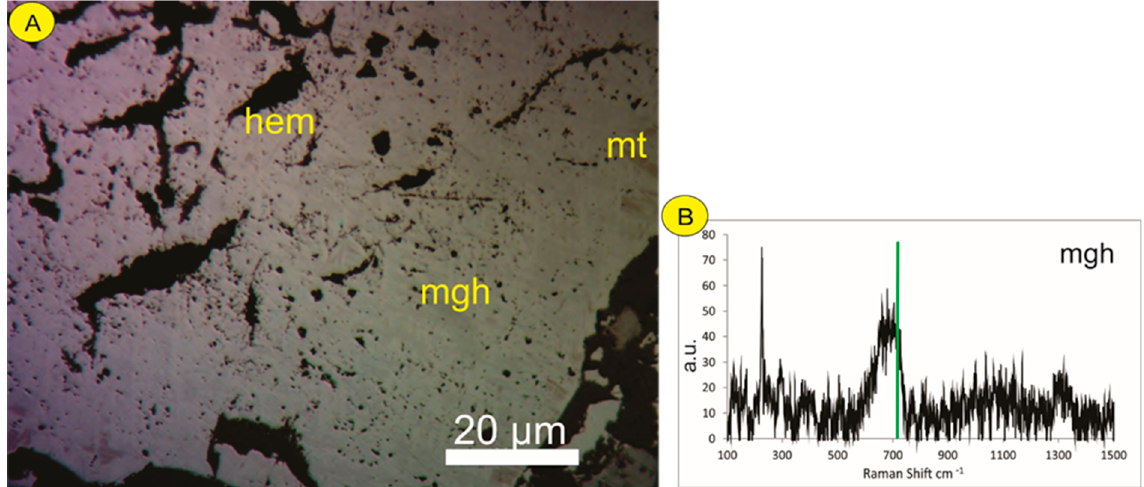
Figure 8. ( A ) Reflected light microscopy bright field image of a small domain of nonstoichiometric magnetite in a hematite grain from a sample from the N4WN mine; ( B ) Raman spectrum of nonstoichiometric magnetite and the diagnostic maghemite vibration at 720 cm − 1 , measured at the mgh domain in ( A ); maghemite domain is probably below the microscope’s resolution, but is still detected by the spectrometer.